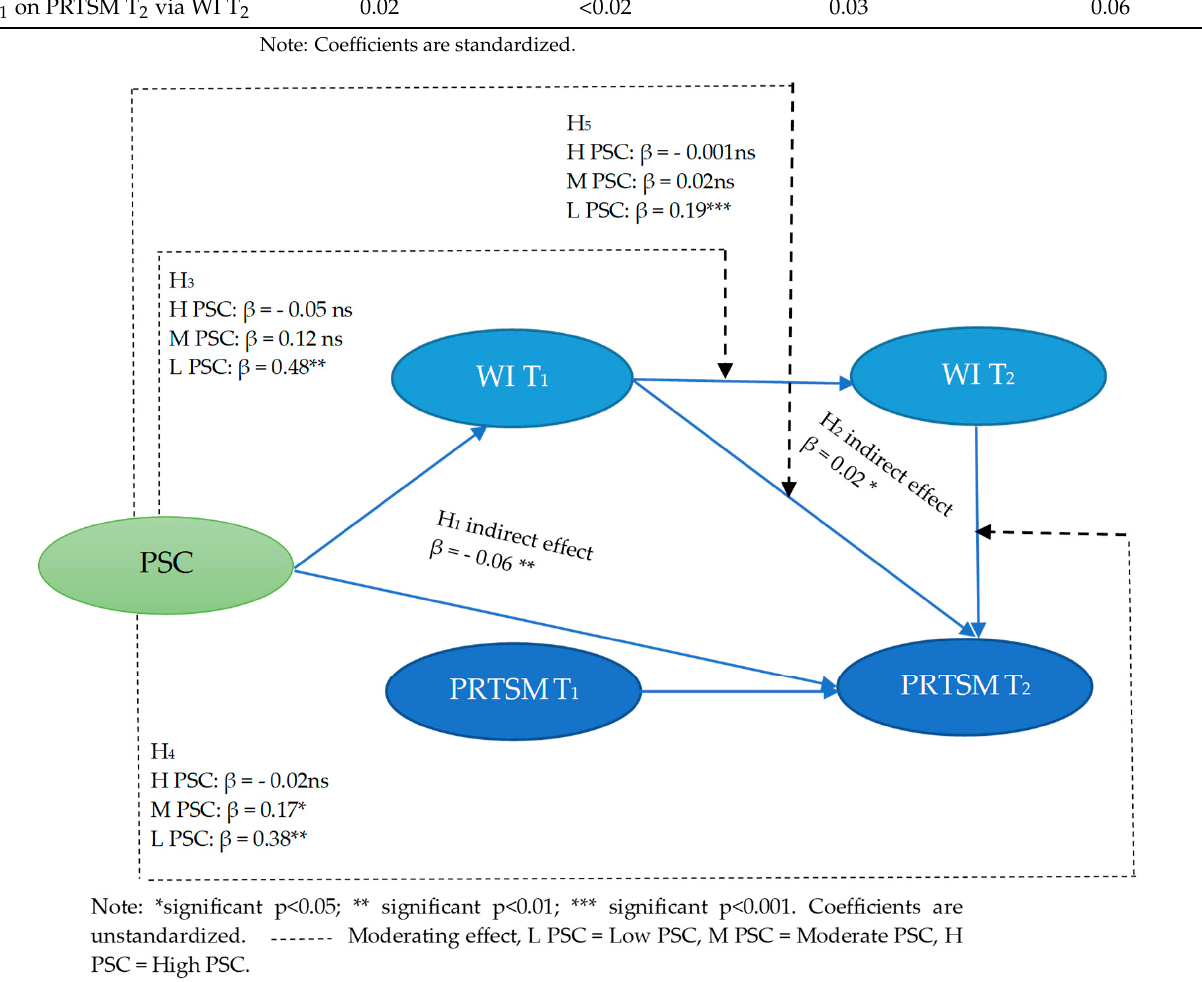
Figure 3. Results of indirect and moderating effects.